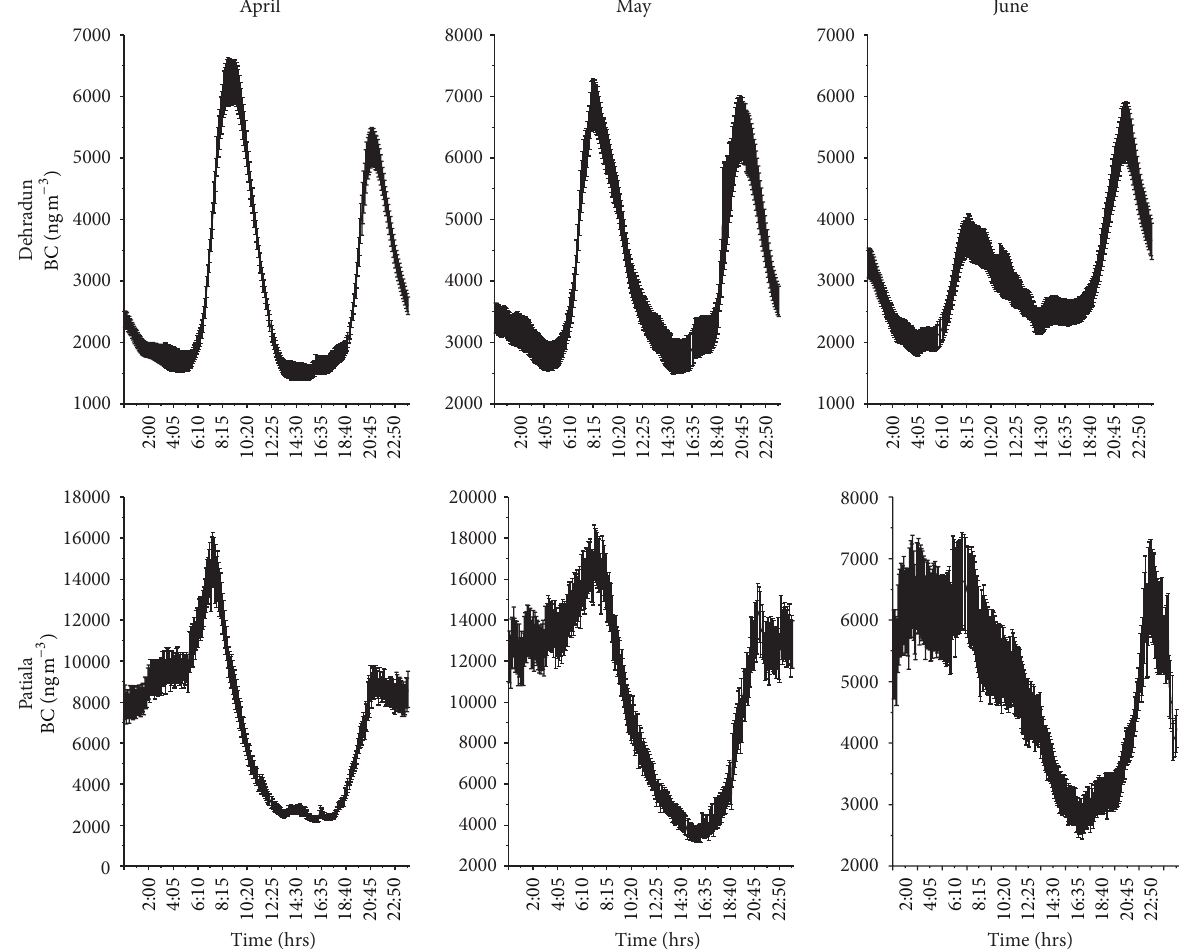
Figure 4: The diurnal variation of monthly average BC aerosol over Dehradun and